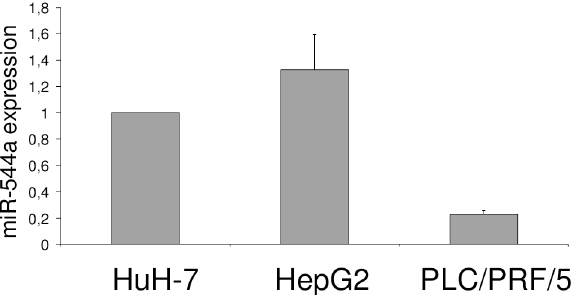
Fig 2. miR-544a expression in three common HCC cell lines. miR-544a expression levels were evaluated by RT-qPCR and reported as fold change relative to that of